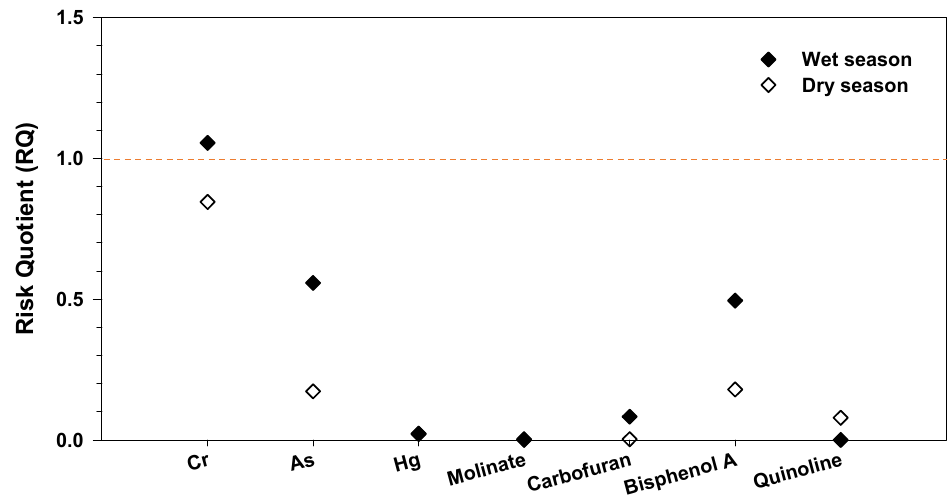
Figure 6. Wet and dry season risk quotients for target compounds in the Han River watershed.